Question: Condense the content of this figure into a single sentence.
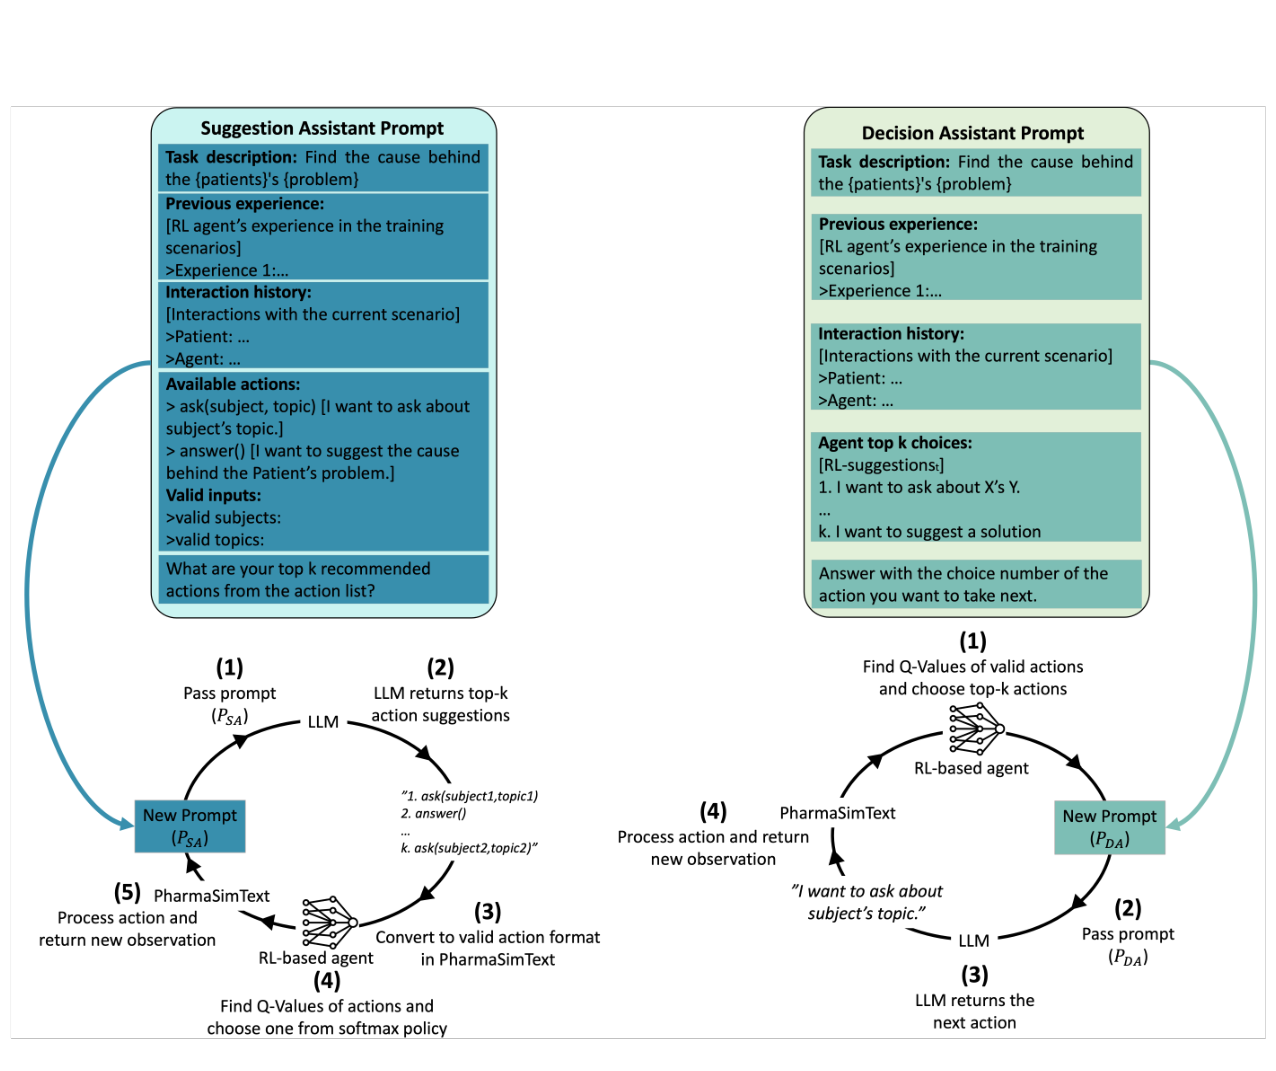
Answer: LLM-assisted RL agents. An LLM is prompted to assist the RL agent at the inference time to aid in generalization. In the Suggestion-Assisted RL (SA-RL) agent (left), the LLM suggests k actions at each step for the RL agent to choose from. In the Decision-Assisted RL (DA-RL) agent (right), the LLM selects an action from the top-k choices provided by the RL agent.